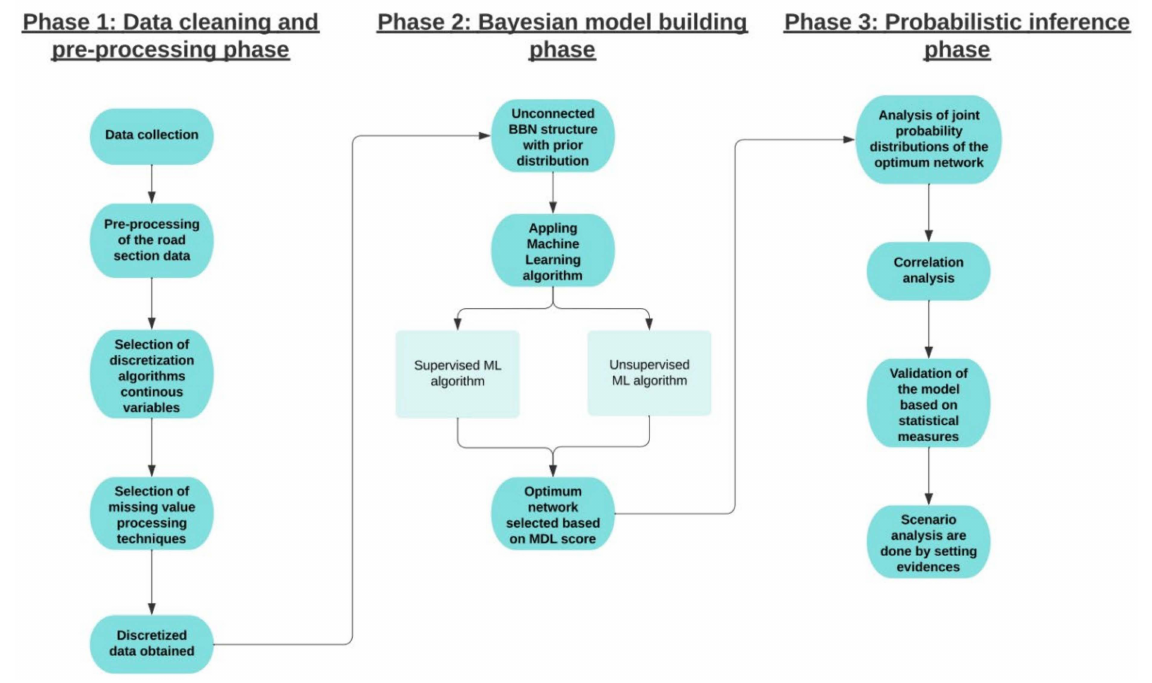
Figure 6. The framework of the proposed BBN